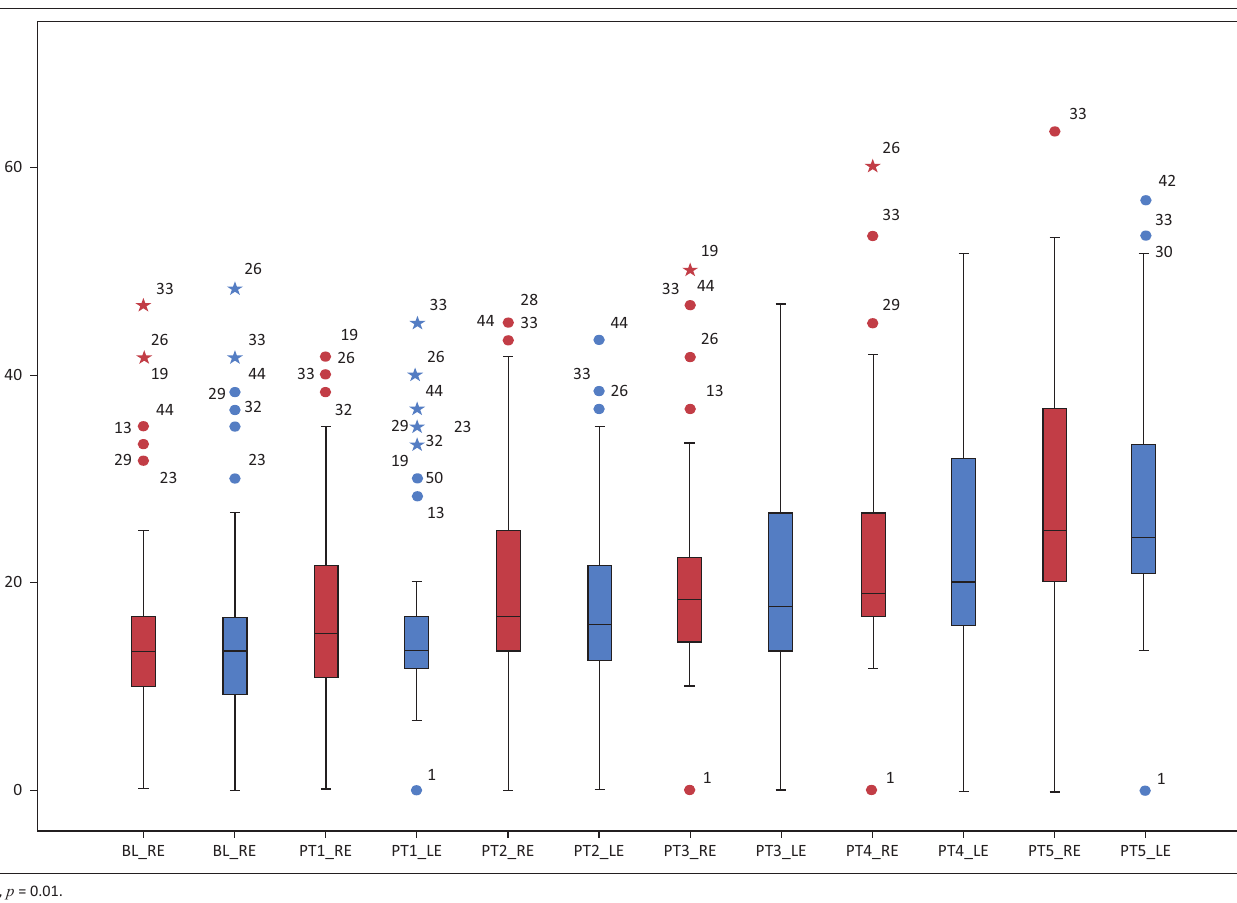
FIGURE 4: Low-frequency threshold changes over treatment